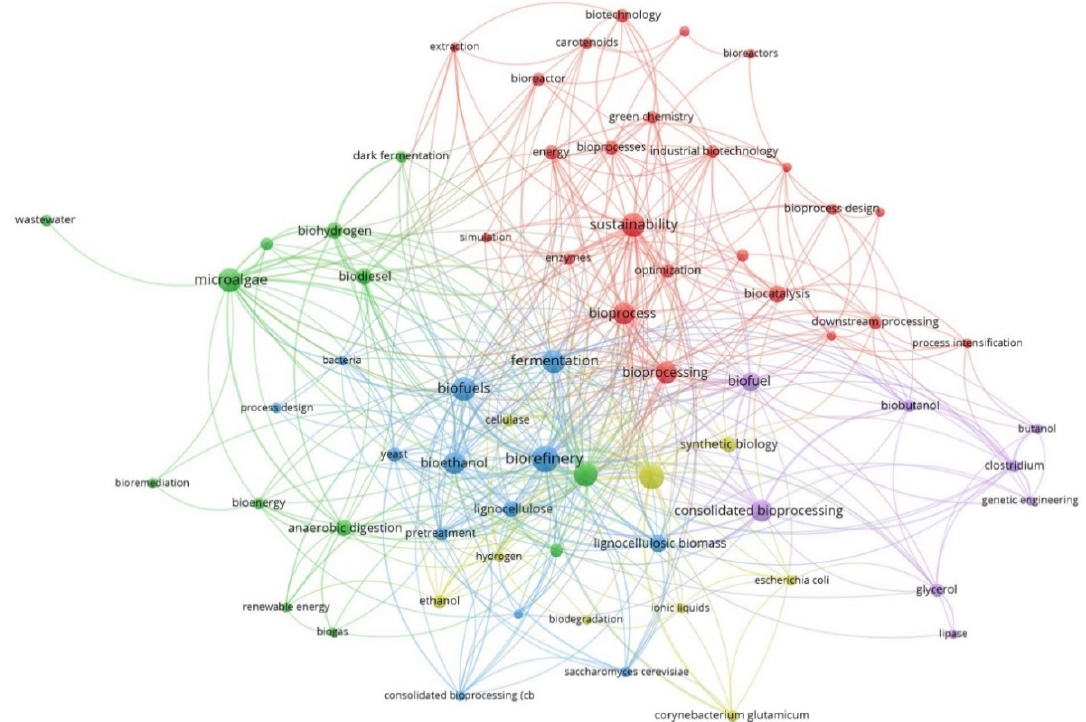
Figure 5. Keyword co-occurrence analysis: (author)-full counting. Source: elaborated by the authors based on Scopus [55].